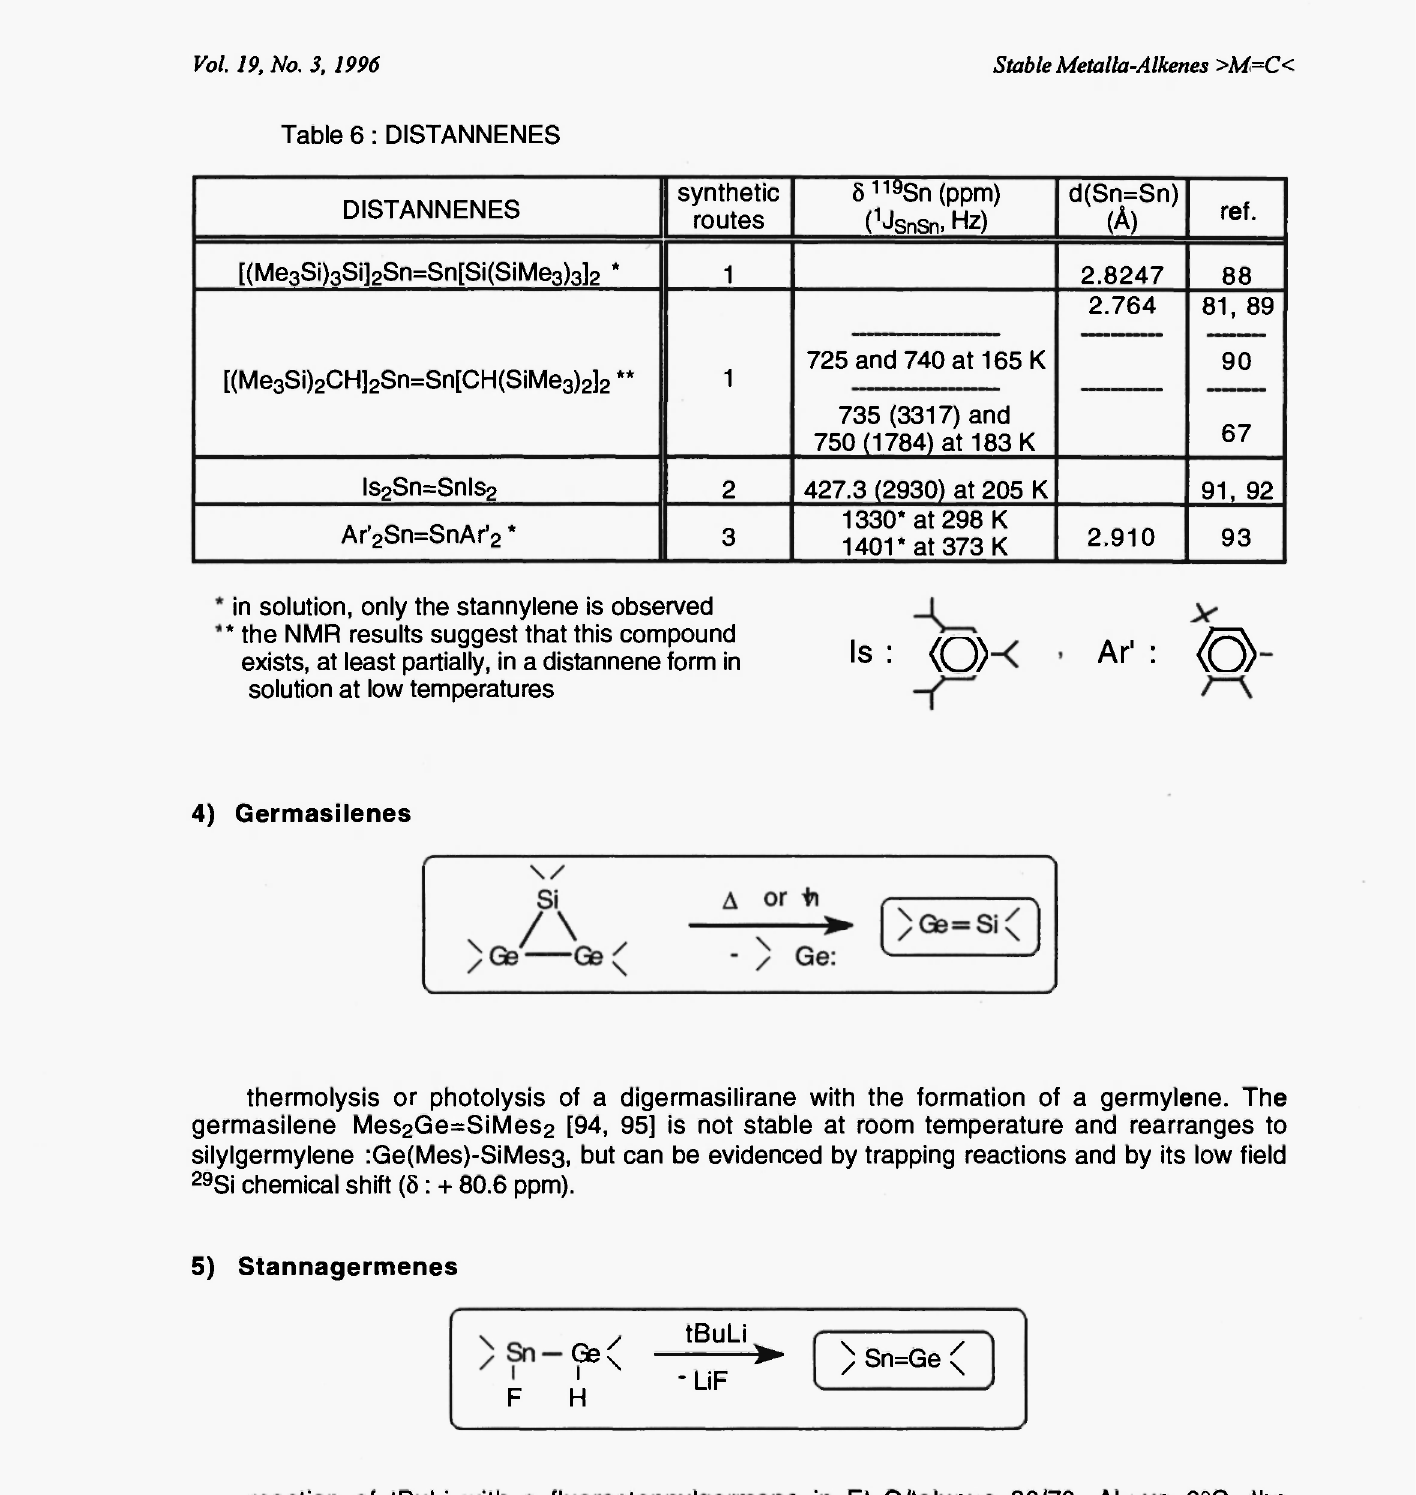
Table 6: DISTANNENES DISTANNENES